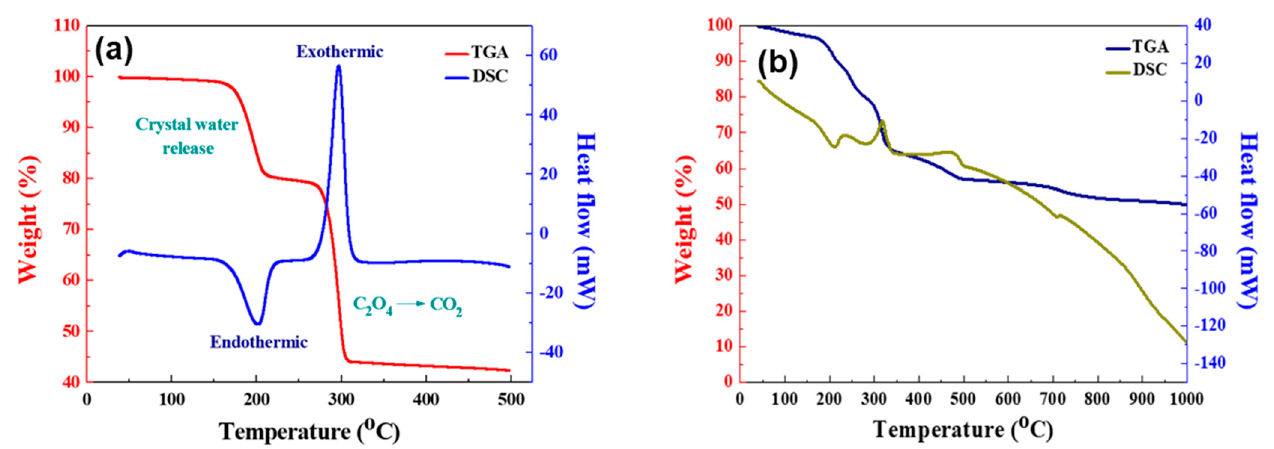
Figure 2. DSC–TGA analyses of ( a ) oxalate SNCM precursor without LiOH and ( b ) oxalate SNCM precursor with LiOH.